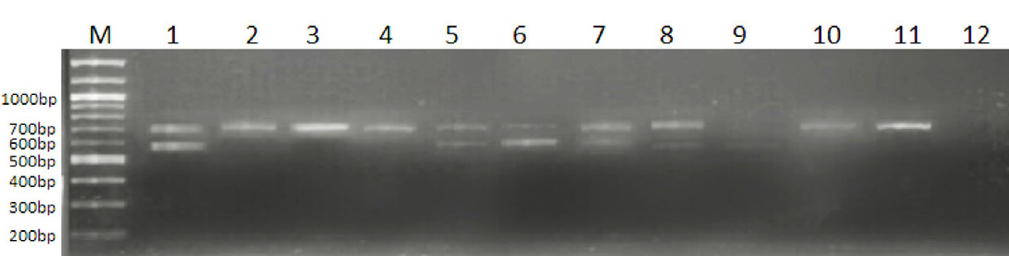
Fig. 4. Multiplex PCR for environmental water samples. Lane M: 100 bp Marker, Lane 1: control plasmid Lipl21 and Lipl32 , Lane 2 to 11: water samples, Lane 12: Negative